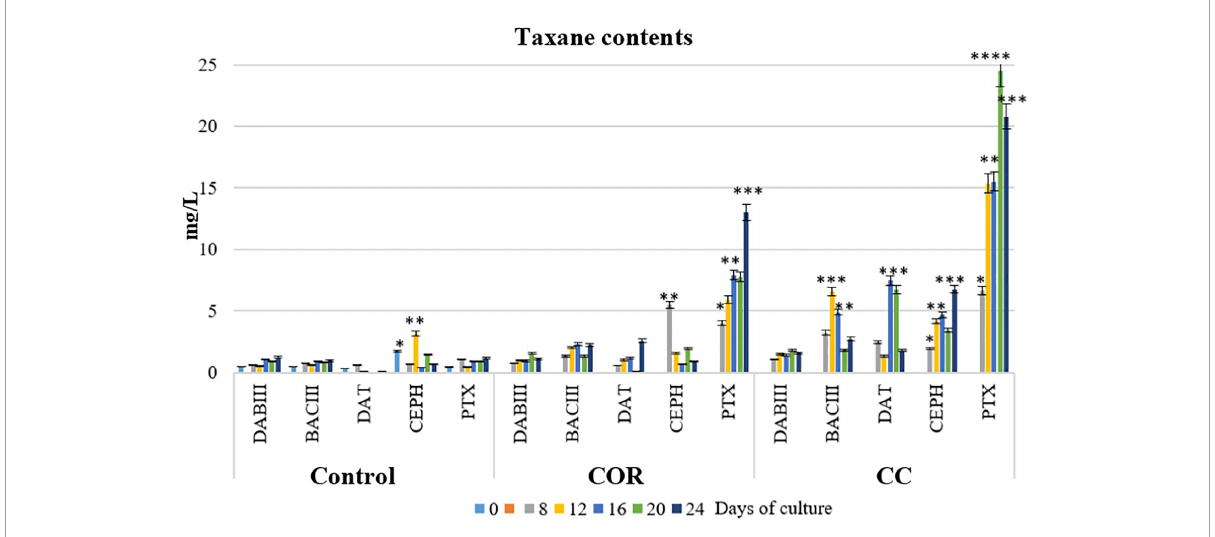
FIGURE6 Contents of the different taxanes studied (accumulated in the cells, in the liquid medium and in LDs) throughout the experiment in T. baccata cell cultures in elicited and control cultures. COR: 1 mM coronatine; CC: 1 mM coronatine + 50 mM β -methyl-cyclodextrins. Values presented are means ± SD ( n = 3). Values followed by different symbols are significantly different ( P ≤ 0.05) according to Tukey’s honestly significant difference